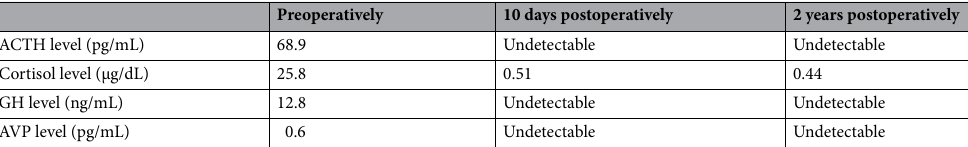
Preoperatively 10 days postoperatively 2 years